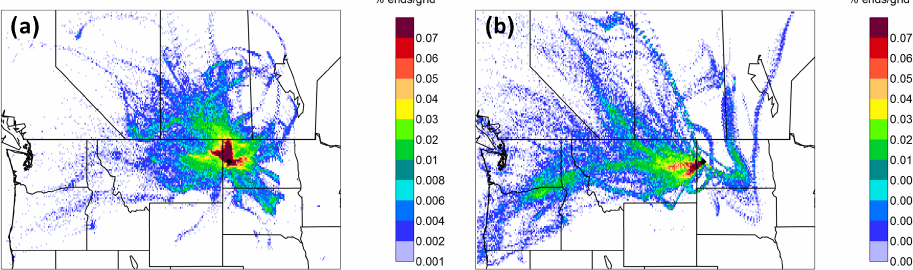
Figure 3. Back trajectory residence times showing areas where air masses resided during the 2days prior to arriving at THRO-N. (a) Tra- jectories arriving when the hourly NO 2 concentration was at the 95th percentile (4.63ppb) or higher for the two Bakken Studies combined. (b) Trajectories arriving when the hourly NO 2 concentration was at the 5th percentile (0.57ppb) or lower for the combined measurements from both studies. Trajectories were generated using the Hysplit Model in ensemble mode with a start height of 10m. All trajectories have a duration of 2days, so longer lengths correspond to higher wind speeds. Note that transport patterns associated with the highest concentrations tend to arrive from a smaller area, indicating probable stagnation, while those associated with the lowest concentrations correspond to travel from more distant areas, indicating high wind speeds, and are more predominantly from the west.